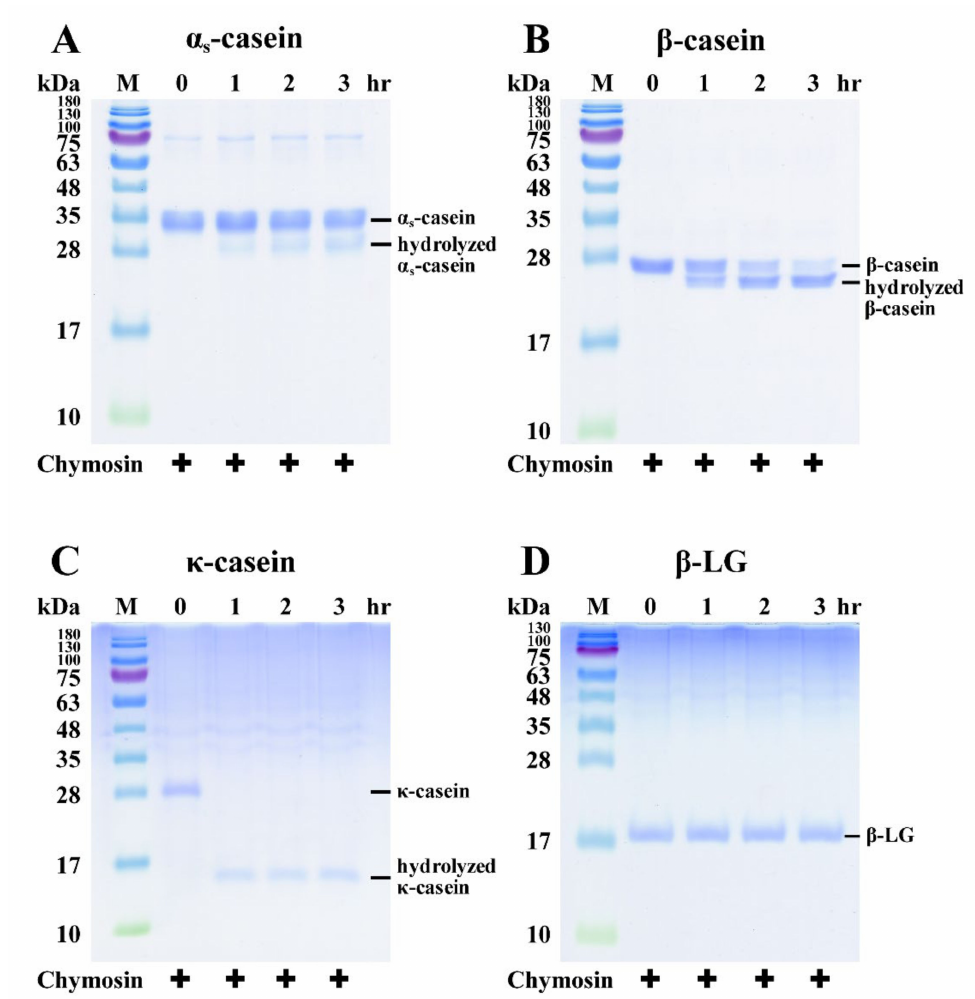
Figure 2. SDS-PAGE analysis of α s -CN, β -CN, κ -CN, and β -LG treated with chymosin (0.03 units/mL) at 30 ◦ C for 0, 1, 2, and 3 h. ( A ) α s -CN; ( B ) β -CN; ( C ) κ -CN; ( D ) β -LG. M = protein marker.